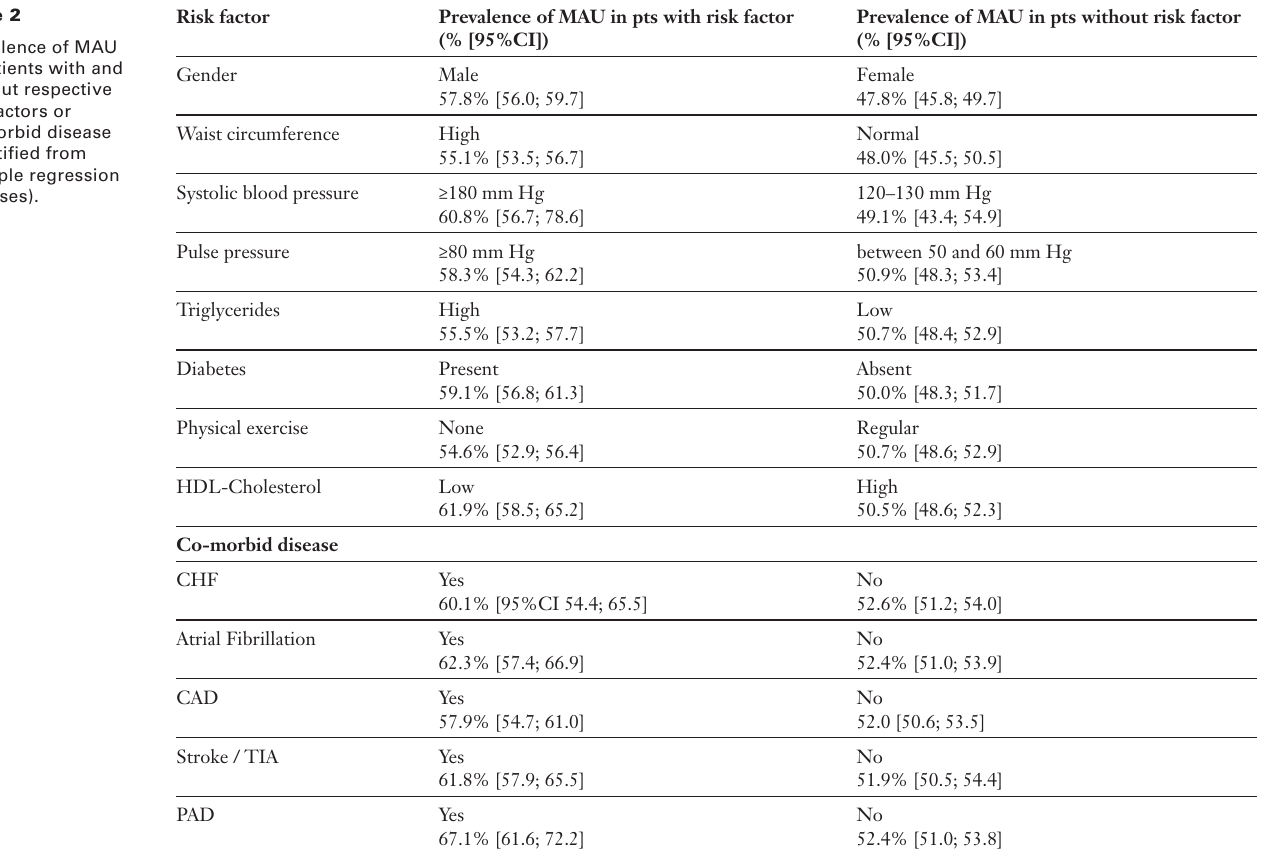
Prevalence of MAU in patients with and without respective risk factors or co-morbid disease (identified from multiple regression